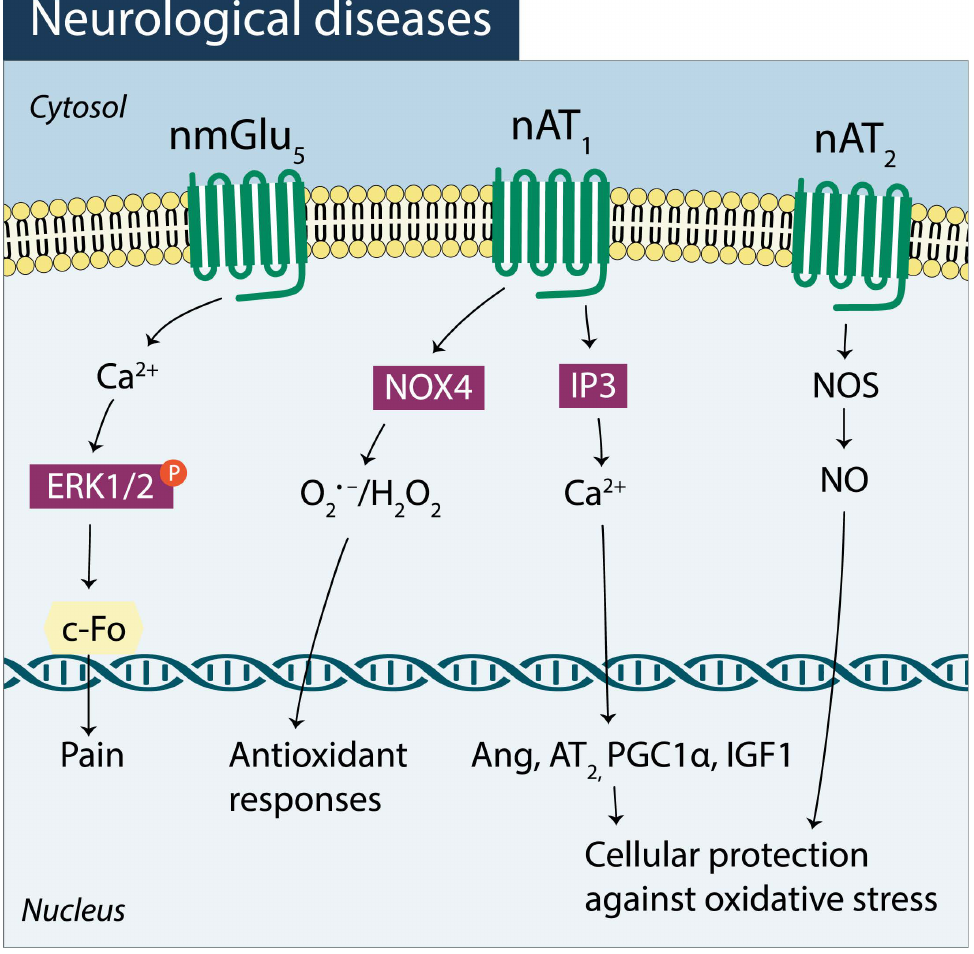
Figure 3. Atypical pathways involving nuclear GPCRs in neurological and neurodegenerative diseases: nuclear metabotropic glutamate type 5 (nmGLU 5 ), nuclear angiotensin type 1 (nAT 1 ) and type 2 (nAT 2 ) receptor activated signaling